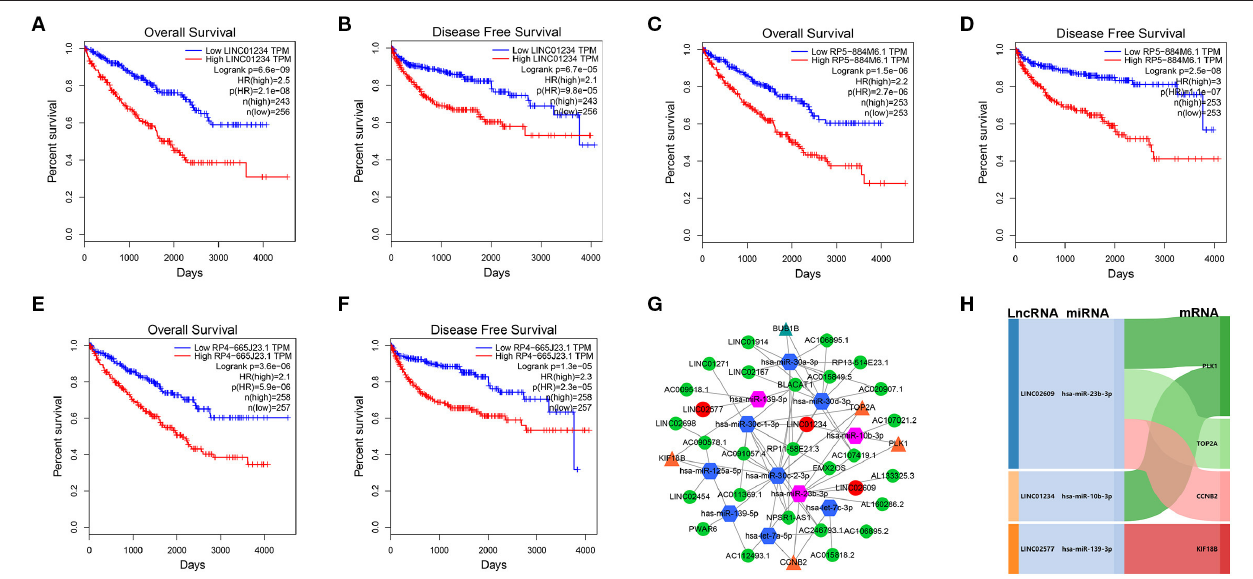
FIGURE 8 | Survival analyses of key lncRNAs and ceRNA network construction. Survival analyses of LINC01234 (A) LINC02577/RP5-884M6.1 (C) , LINC02609/RP4-665J23.1 (E) in OS, and survival analyses of LINC01234 (B) , LINC02577/RP5-884M6.1 (D) , LINC02609/RP4-665J23.1 (F) in DFS. (G) ceRNA network of the 11 tumor suppressor miRNAs and their interactions in pink module. The green circle represents non-key lncRNA, the red circle represents key lncRNA, the blue hexagon stands for prognostic miRNA, the red hexagon stands for prognostic and distant metastatic miRNAs, the yellow triangle means hub mRNAs that are related to key miRNAs, and the green triangle means hub mRNAs that are only associated with prognostic miRNAs. (H) The core ceRNA network associated with distant metastasis and prognosis of patients with ccRCC was presented by Sankey diagram. The value of p < 0.05 was considered statistically significant. lncRNAs, Long non-coding RNAs; ceRNA, competitive endogenous RNA; OS, overall survival; DFS, disease free survival.